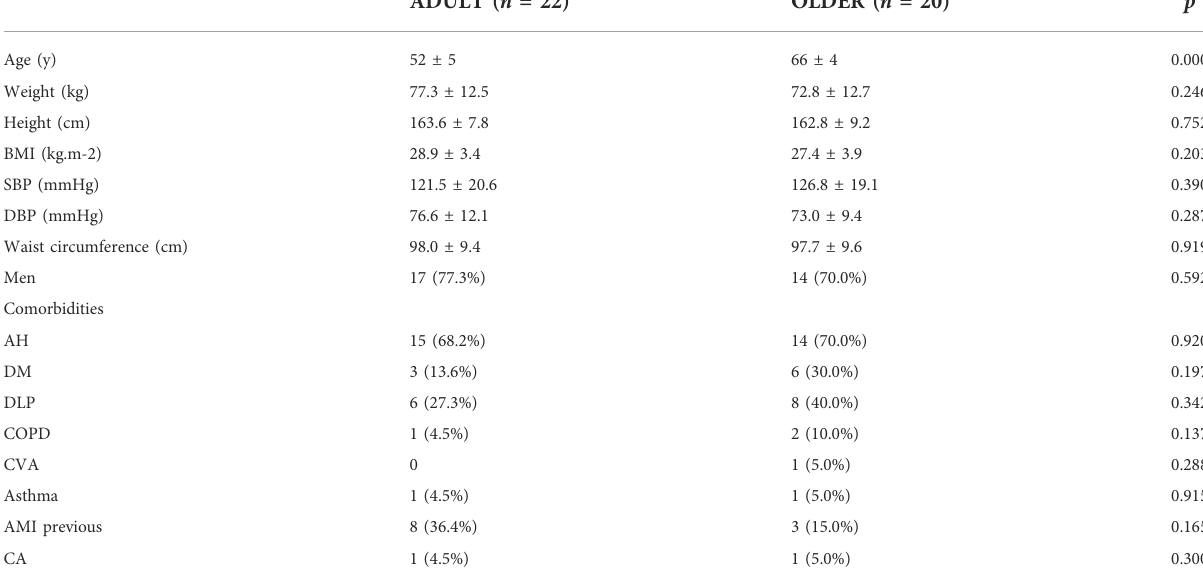
Data are means ± SD, and frequency (percentage). Data were analyzed using an independent samples t-test for quantitative variables and a Chi-square test for qualitative variables. BMI, body mass index; SBP, systolic blood pressure; DBP, diastolic blood pressure; y, years; cm, centimeters; kg, kilograms; m, meters; mmHg, millimeters of mercury; AH,